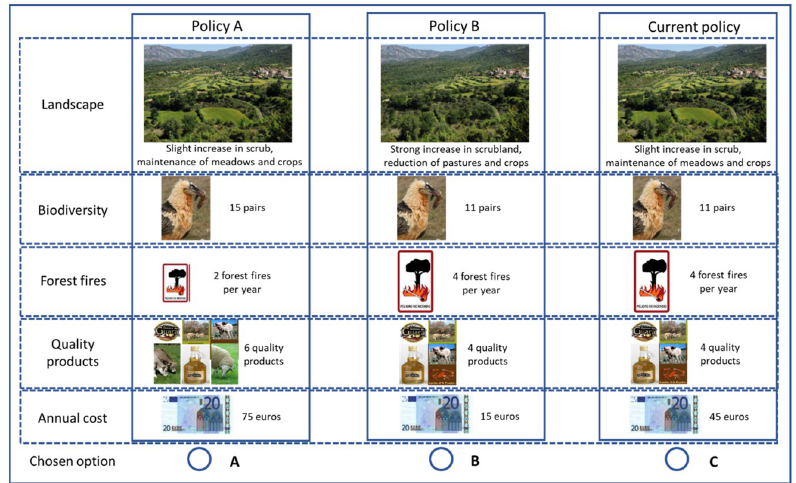
Fig 1. Example of the choice set presented to the respondents in the Spanish ‘Sierra y Ca ñ ones de Guara’ Natural Park. From [25]. Policy A, B, and Current policy, refers to ES improvement, decrease, and maintenance, respectively.